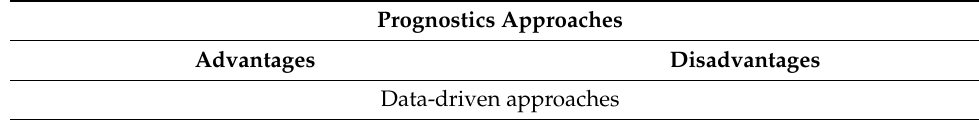
Table 1. Prognostics